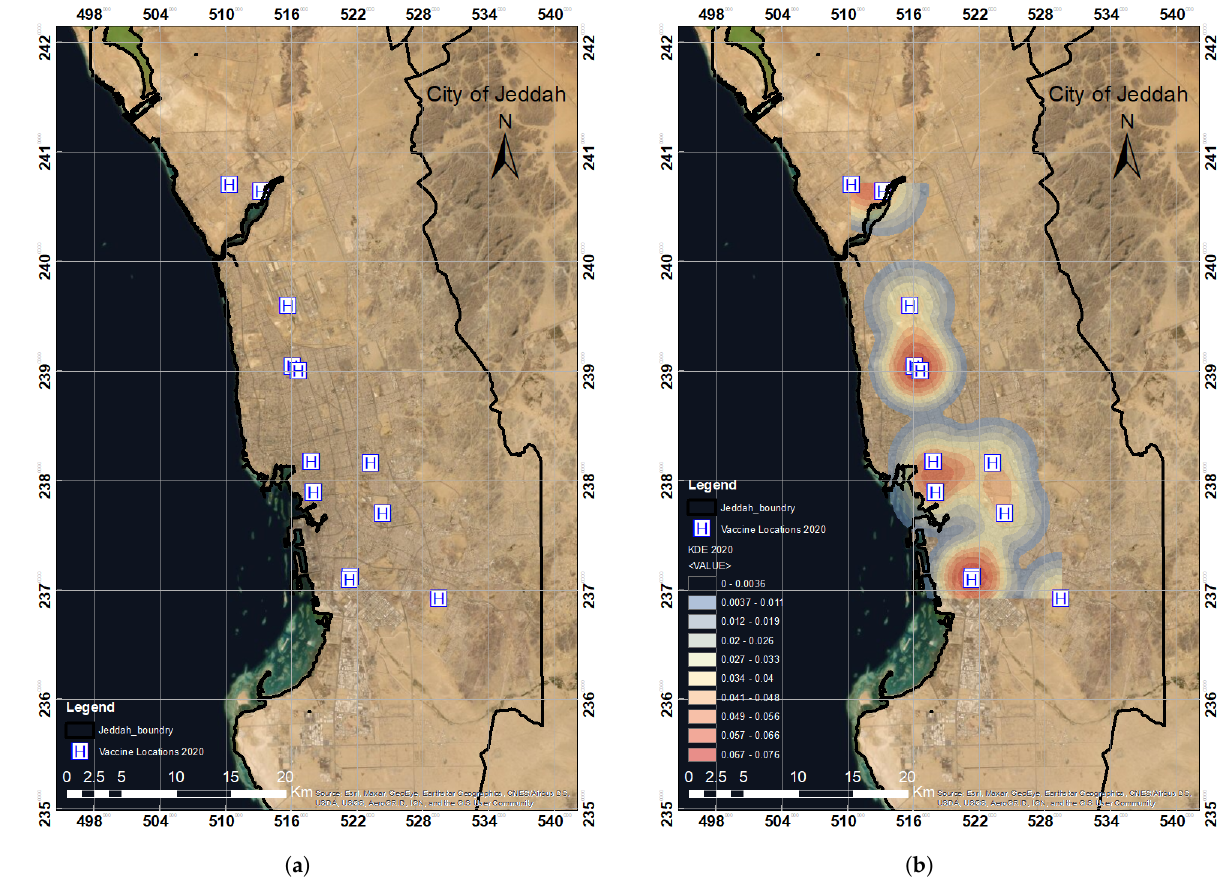
Figure 7. The spatial distribution of COVID-19 vaccination centers in 2020 in Jeddah ( a ) and the KDE analysis over all the initial 12 vaccination locations in Jeddah in 2020 ( b ). ( a ) Spatial distribution map of the vaccination centers in 2020. ( b ) KDE analysis of vaccine locations in